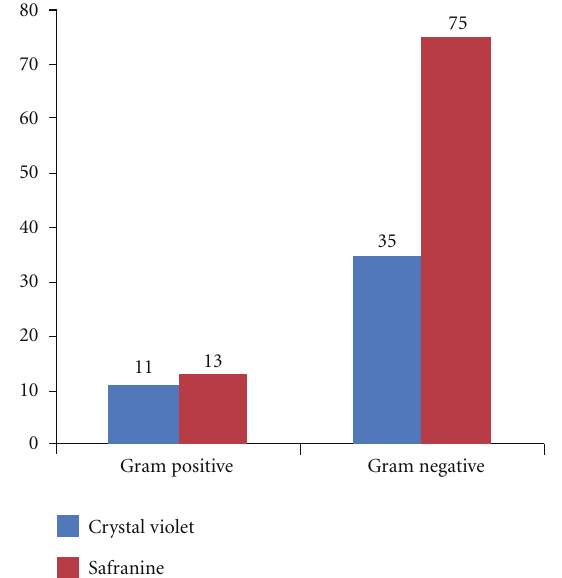
Figure 1: Showing ability of safranine and crystal violet staining methods to detect biofilms by microtitre plate